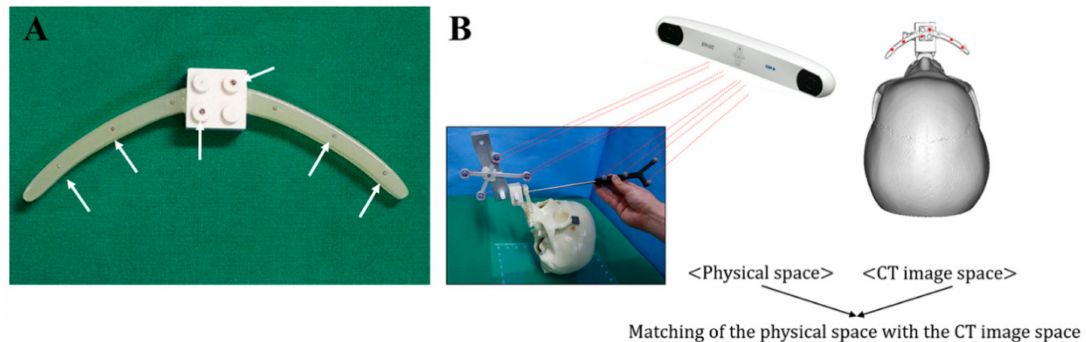
Figure 2. Preoperative registration. ( A ) Registration body including the fiducial markers (arrow). ( B ) Matching of the physical space with the CT